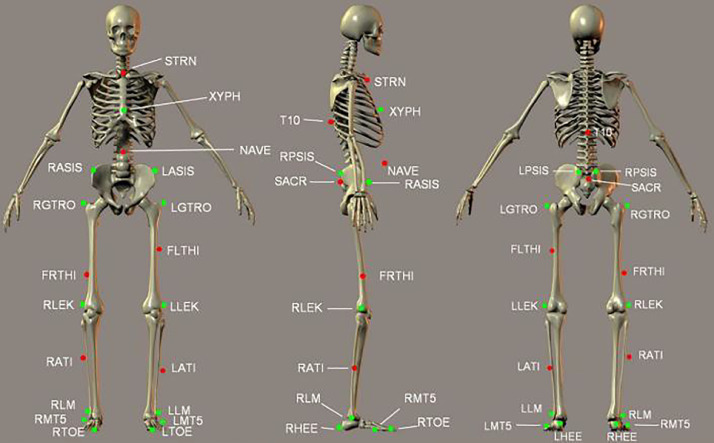
Diagram of markers.